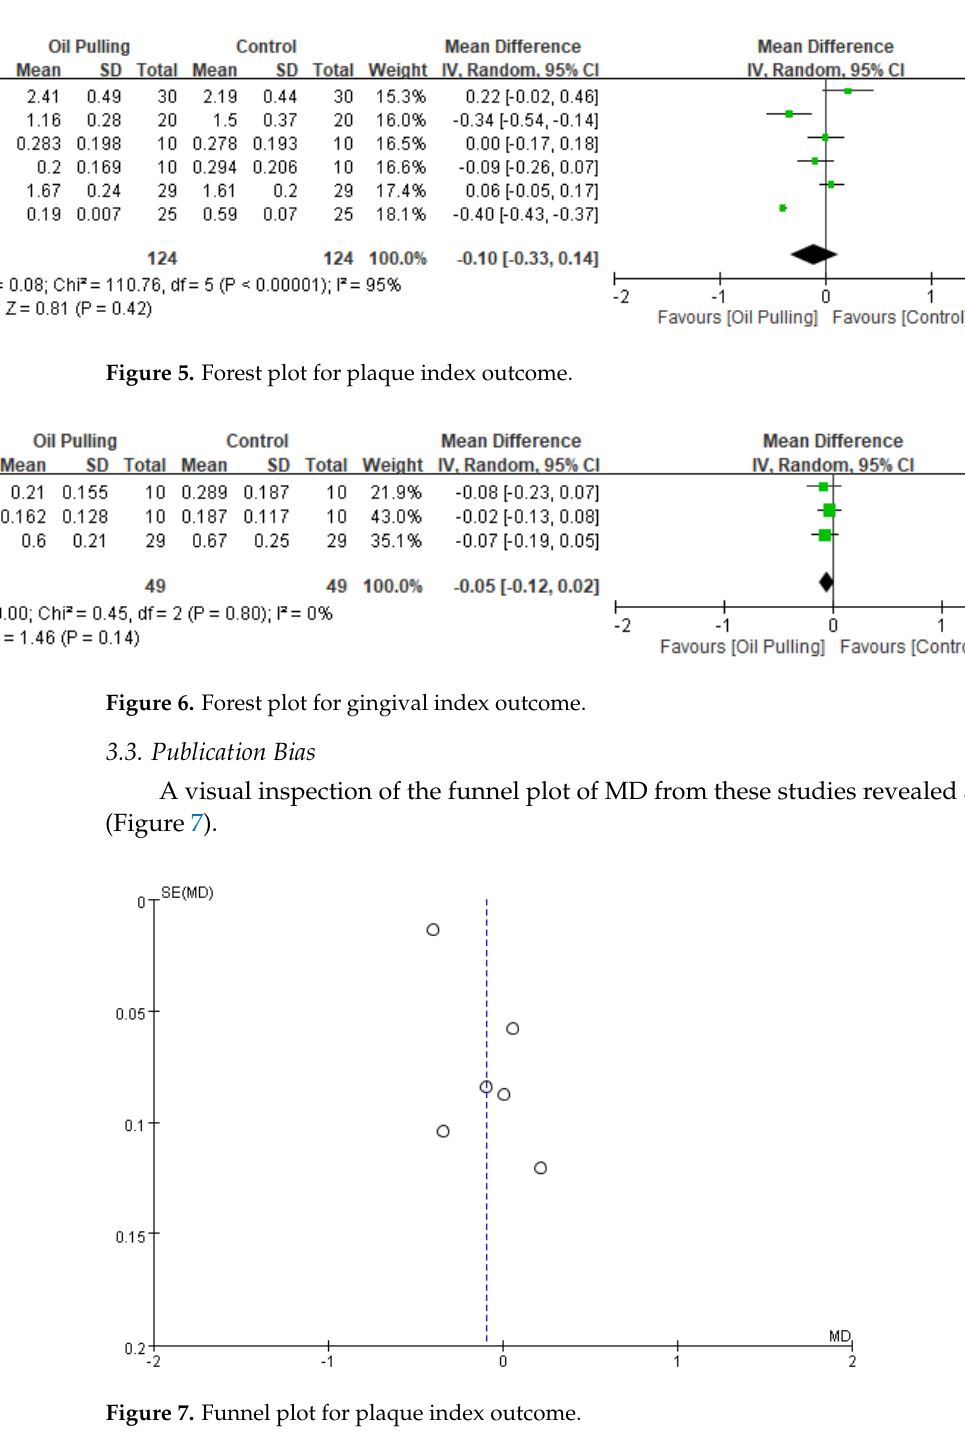
Figure 4. Forest plot for the salivary bacterial colony (BC) count.